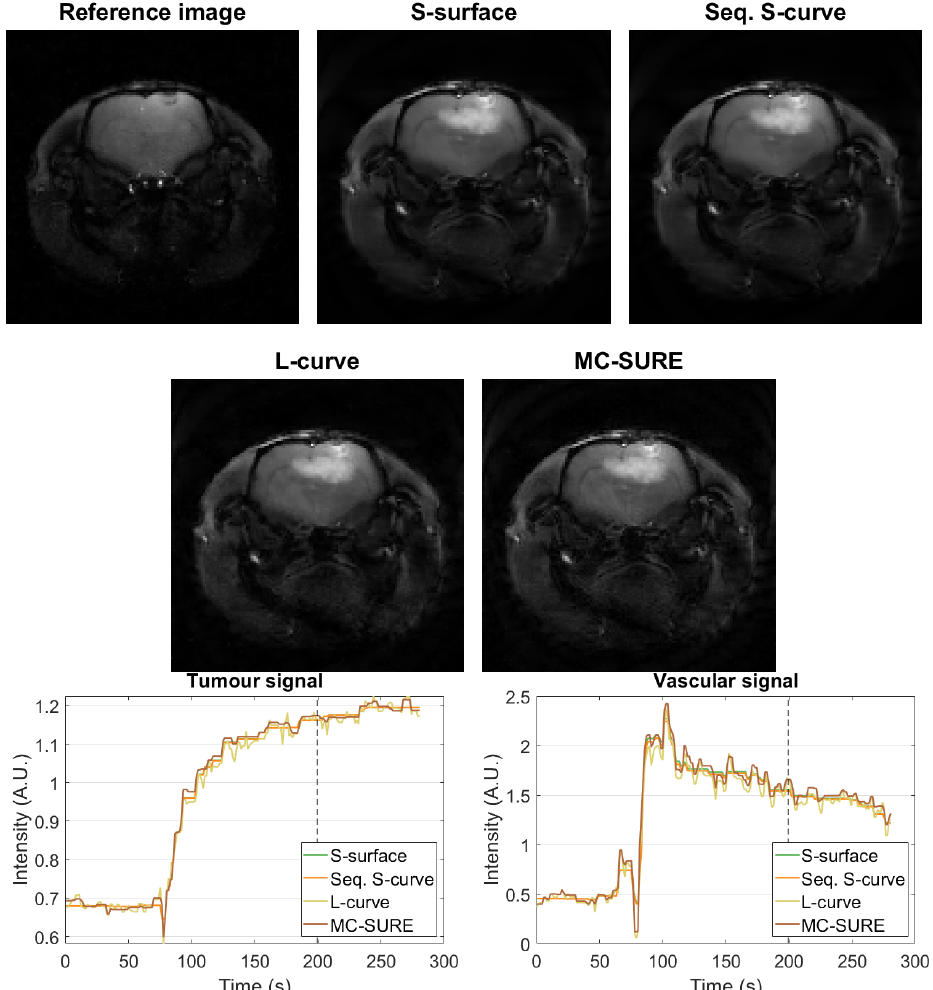
Figure 7. Top rows: Single frame images of the cartesian reference image with spatial regularization from before contrast agent injection and the reconstructions of the experimental data at t ≈ 200 s (marked below with a dashed line) with parameters chosen with the S-surface, Sequential S-curve, L-curve and MC-SURE methods. Bottom row: Single pixel signals from the tumour and vascular areas with the four different